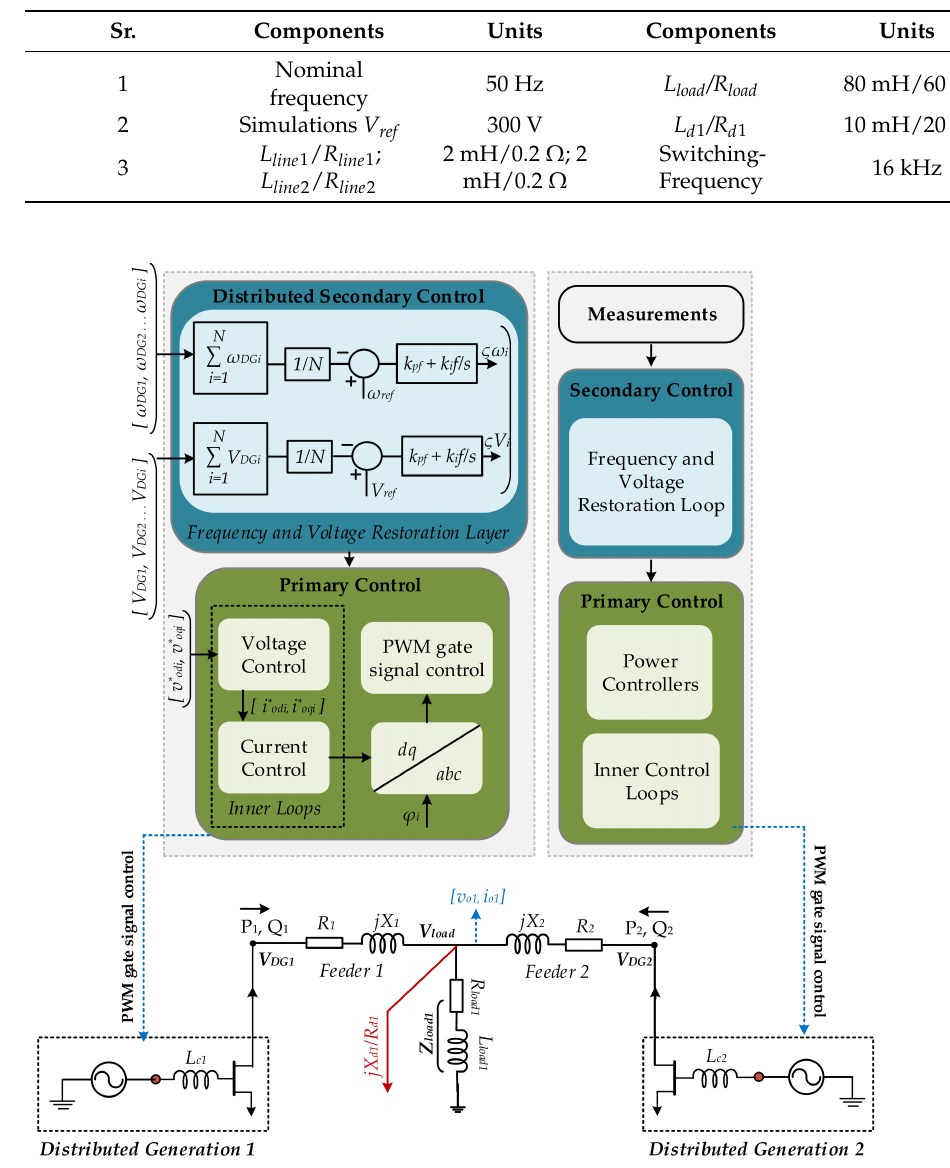
Figure 1. MG power network model and proposed control